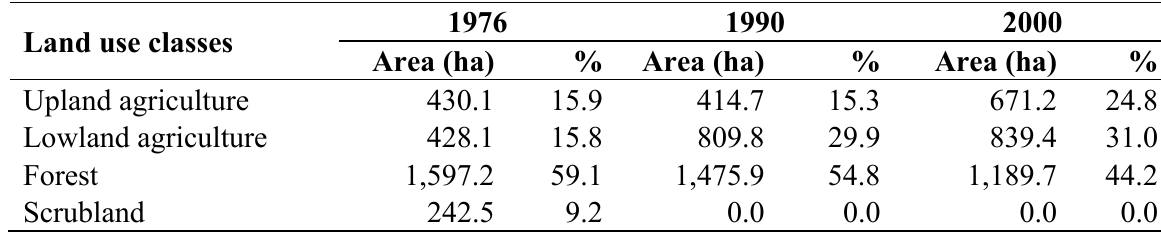
Table 4. Land uses of Galaudu watershed, Nepal, 1976, 1990 and